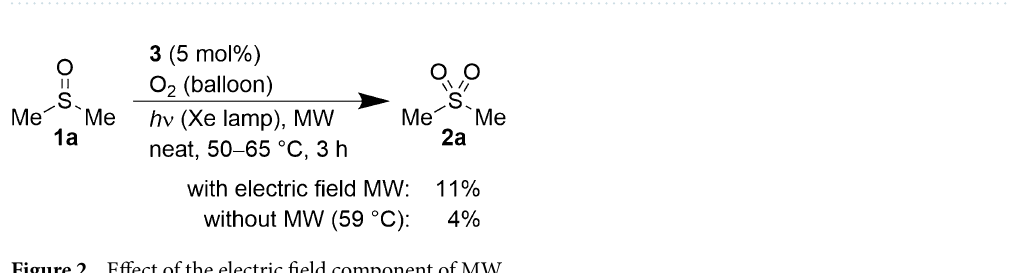
Figure 1. Substrate scope. a Reaction conditions: 1 (5.0 mmol) and 3 (0.25 mmol) were used in dry-toluene (2.0 mL) with O 2 balloon under white light irradiation using a Xe lamp (30 mW/cm 2 at 450 nm) and MW irradiation (8 W) at 50 °C. Yields were determined using 1 H NMR with 1,3,5-trimethoxybenzene as the internal standard. The Numbers in parentheses mean the rate of substrate recovery. a,b 1a (15 mmol) and 3 (0.75 mmol) were used without any solvent. c 1.0 mL of dry-toluene was used.